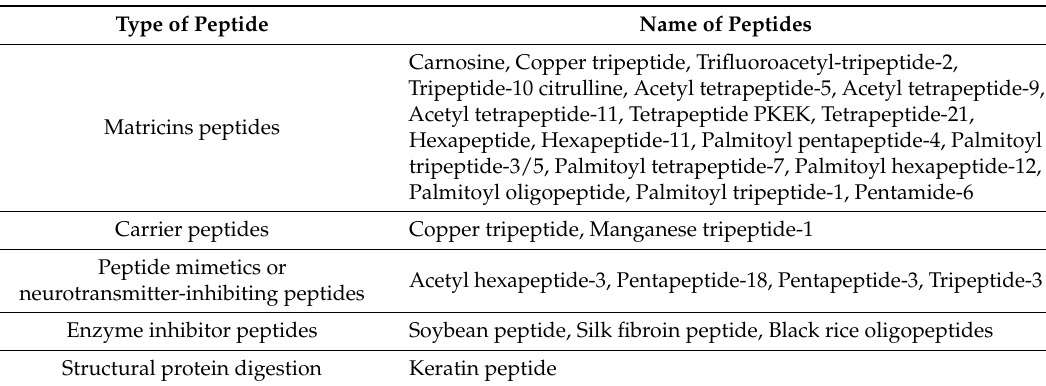
Table 1. Topically used